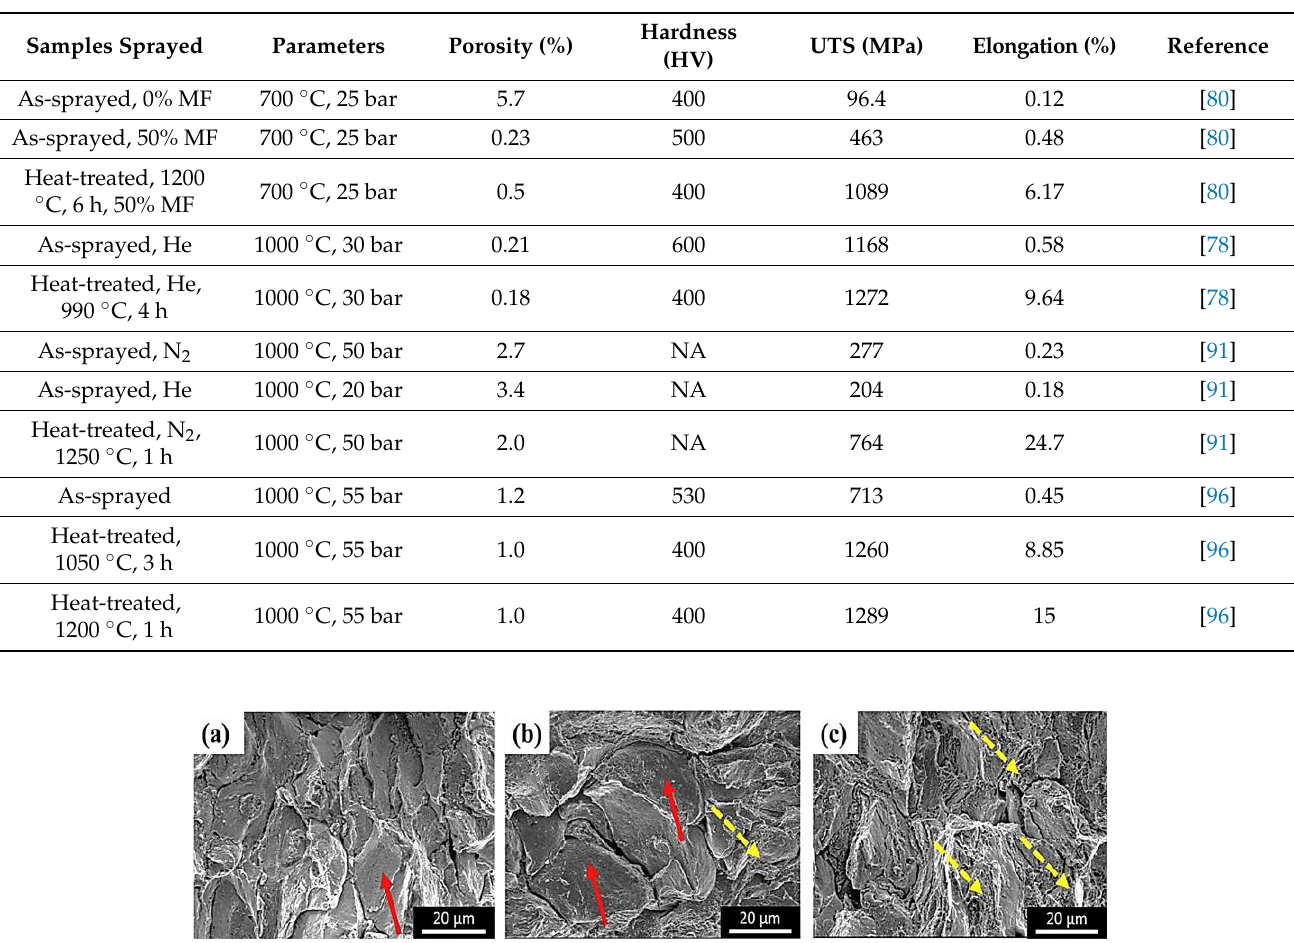
Table 2. A summary of changes in porosity, hardness, ultimate tensile strength (UTS), and elongation between different cold-sprayed samples of IN 718 produced with N 2 and He (as the process gases), micro-forging (MF), and various heat treatments [78,80,91,96].